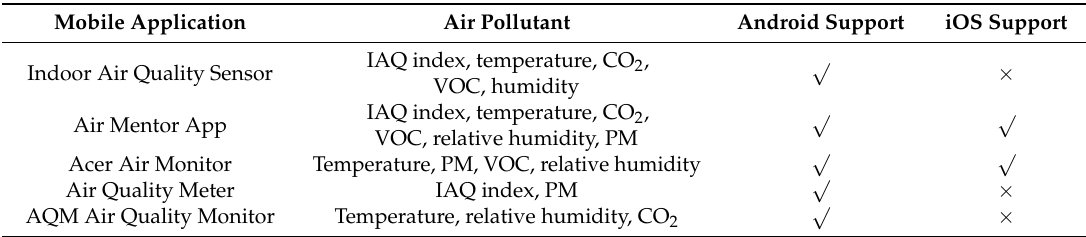
Table 4. IAQ mobile applications available on marketplaces.